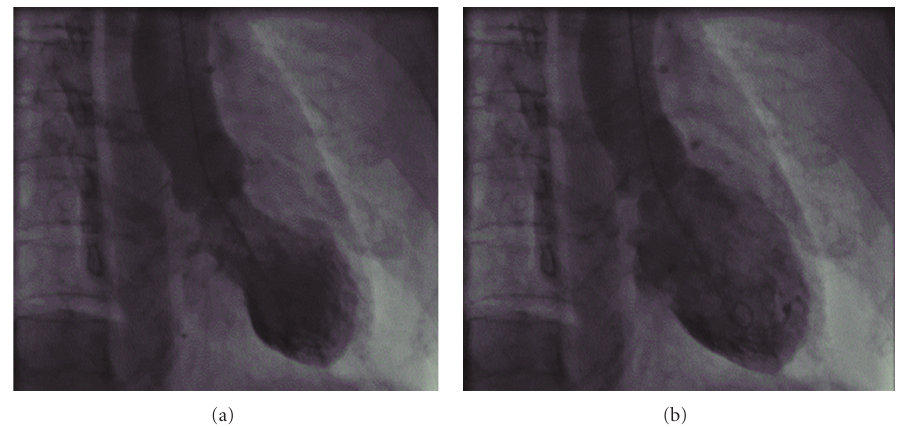
Figure 2: Left ventriculography ((a) systole, (b) diastole) demonstrates akinesis of the apex with systolic ballooning. Table 2: Hormonal data in detailed